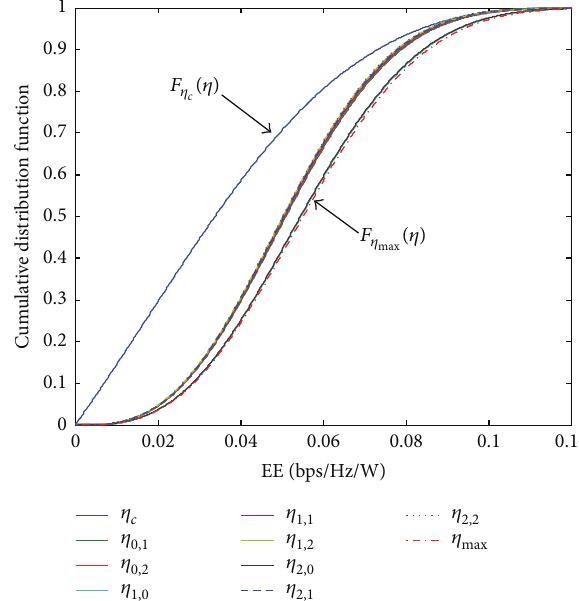
Figure 7: EE distributions for CS-DAS with CoAU-3 transmission scenario and traditional cellular